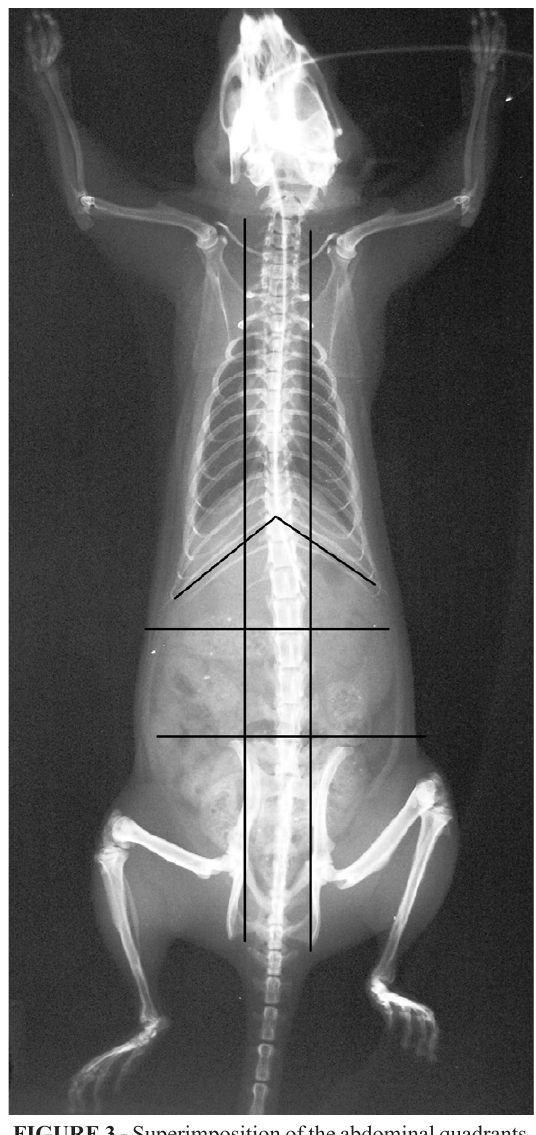
FIGURE 4 - Presence of contrast in the esophagus, stomach and duodenum in the anteroposterior incidence